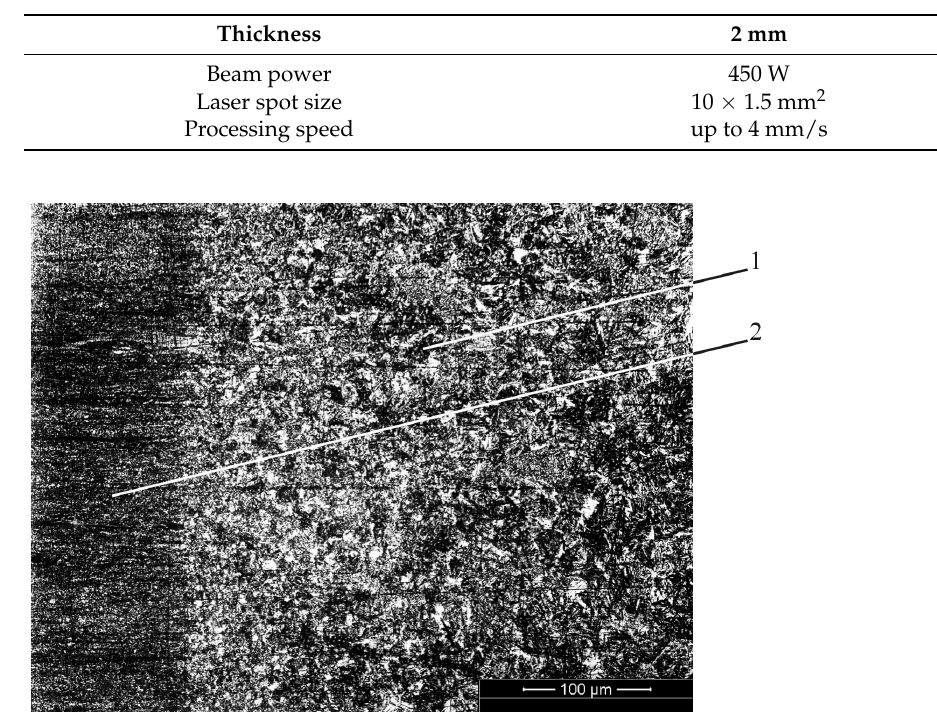
Table 3. Conditions for laser annealing of a low-alloyed titanium alloy.